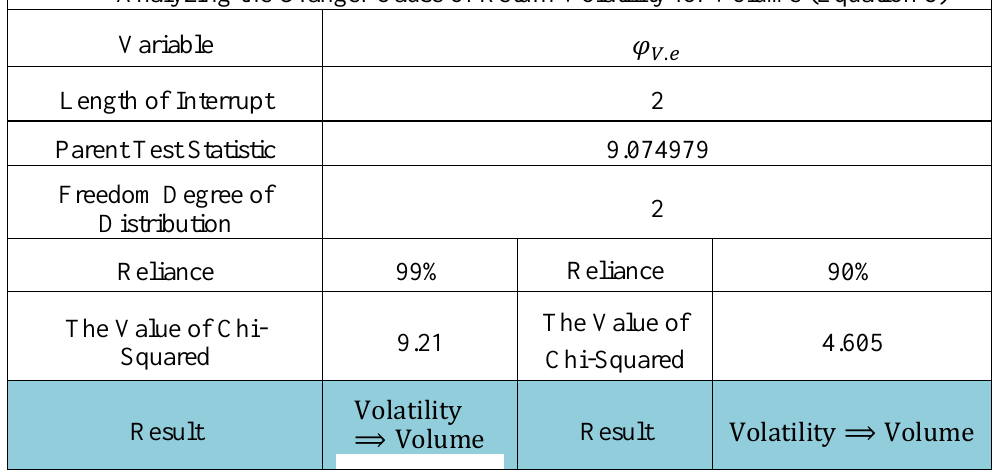
Table 3. The Estimation Results of the Conditional Mean Volume (Volatility-Volume) Analyzing the Granger Cause of Return Volatility for Volume (Equation